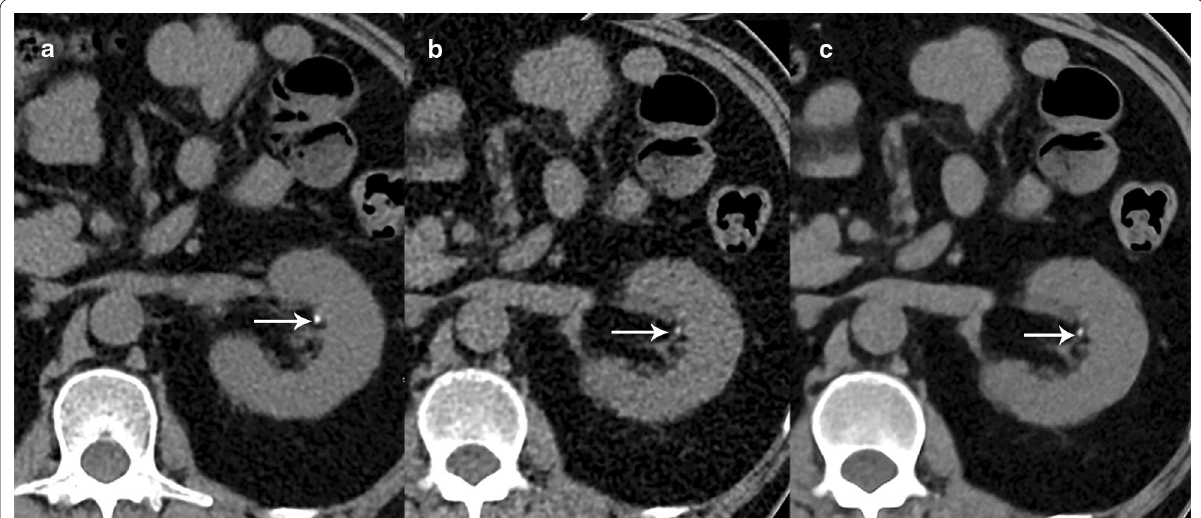
Fig. 2 CT images from an 81-year-old female patient with a clinically suspected renal calculus. A left renal calyceal calculus 1.9 mm in diameter was detected on all the three images. However, LD-HIR ( a ) was clearest, followed by ULD-DLR ( c ), while ULD-HIR ( b ) was the least clear. LD-HIR means low-dose computed tomography with hybrid iterative reconstruction. ULD-HIR means ultra-low-dose computed tomography with hybrid iterative reconstruction. ULD-DLR means ultra-low-dose computed tomography with deep learning reconstruction